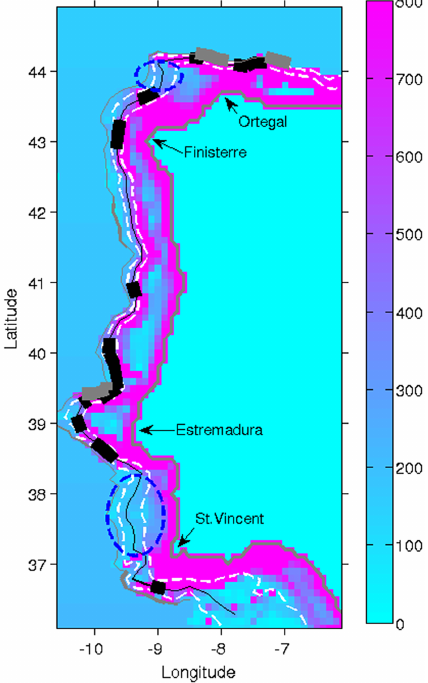
Figure 14. Topographic β effect, planetary β effect and JEBAR along the Iberian margin. Spatial distribution of R β . The thickness of 1000m isobath (solid black line) and 2000m isobath (solid grey line) shows the effect of JEBAR relative to the topographic β effect. Isobaths of 500m and 1500m (white dashed lines) are